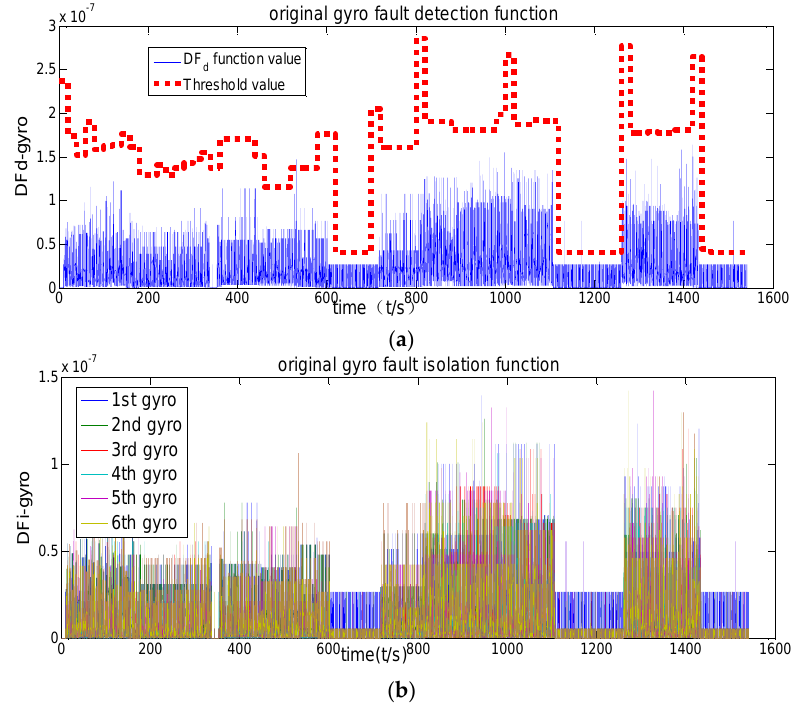
Figure 5. Original channel filter (the fault amplitude is 5 / h ). ( a ) Fault detection; ( b ) Fault isolation.